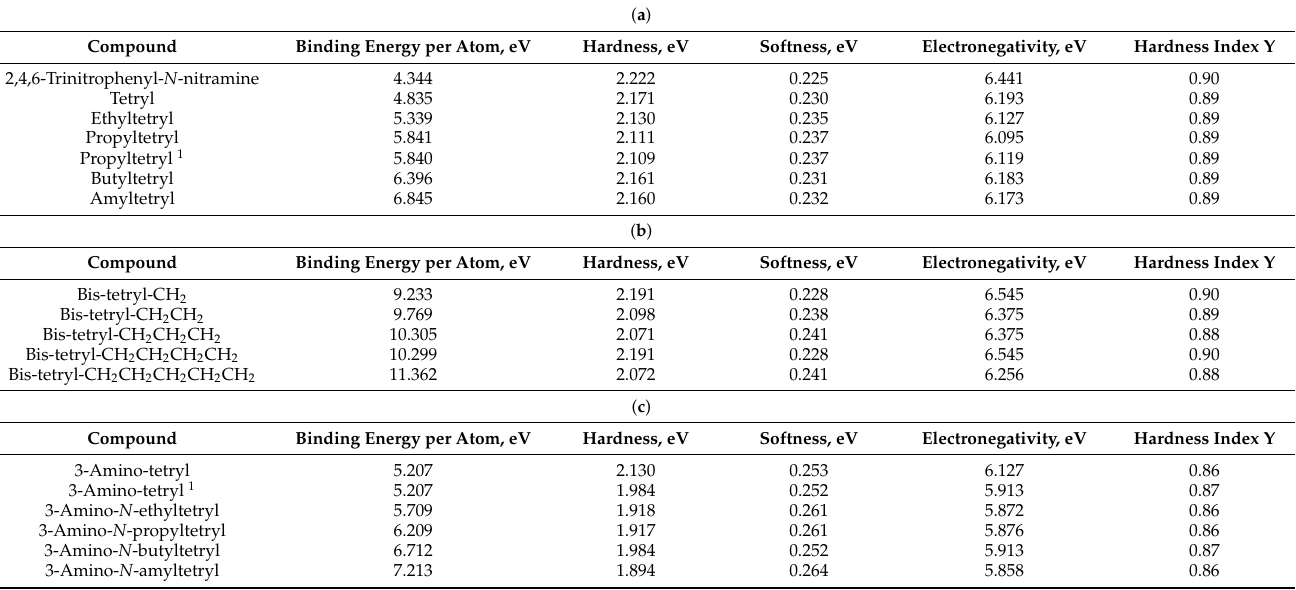
Table 1. The parameters describing the chemical and thermal stability of the compounds belonging to. ( a ) Homologous aromatic N -nitramines, tetryl derivatives [(2,4,6-trinitrophenyl-(O 2 N)N(CH 2 ) n H, n = 0–5]. ( b ) Bis-aromatic homologs of chain length variation (CH 2 ) n of [(2,4,6-trinitrophenyl- N(NO 2 )] 2 (CH 2 ) n , ( n = 1–5)]. ( c ) 3-Amino derivatives of tetryl with chain length variation [(3-amino-